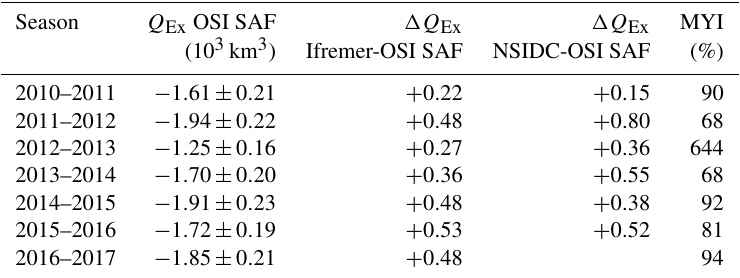
Table 3. Total Arctic sea ice volume export through the Fram Strait for winter seasons 2010–2011 and 2016–2017, added together over the November–April period. Volume export has been computed using three different ice drift products, using Q Ex , OSISAF as the reference product. The last column shows the fraction of exported multi-year sea ice (%